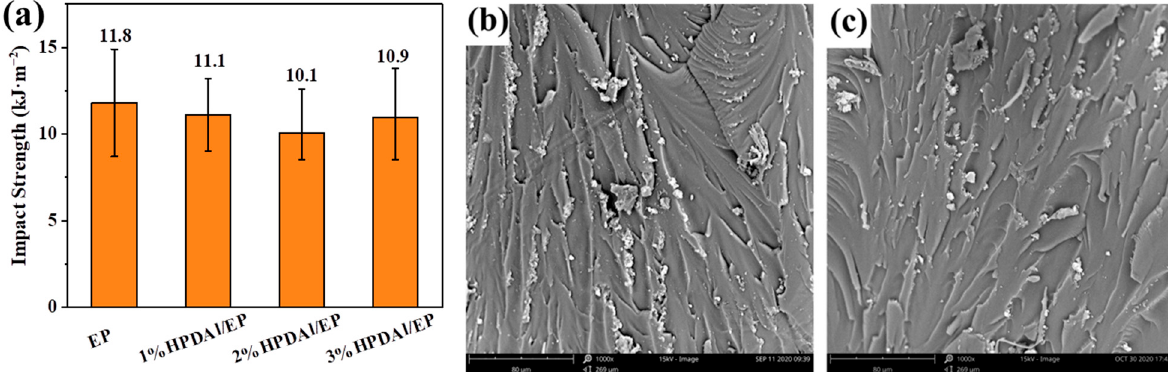
Figure 8. Impact strength ( a ) of epoxy composites and microtopography for the impact fractured surface of EP ( b ) and 2%HPDAlEP ( c ) composites (SEM-1000X).